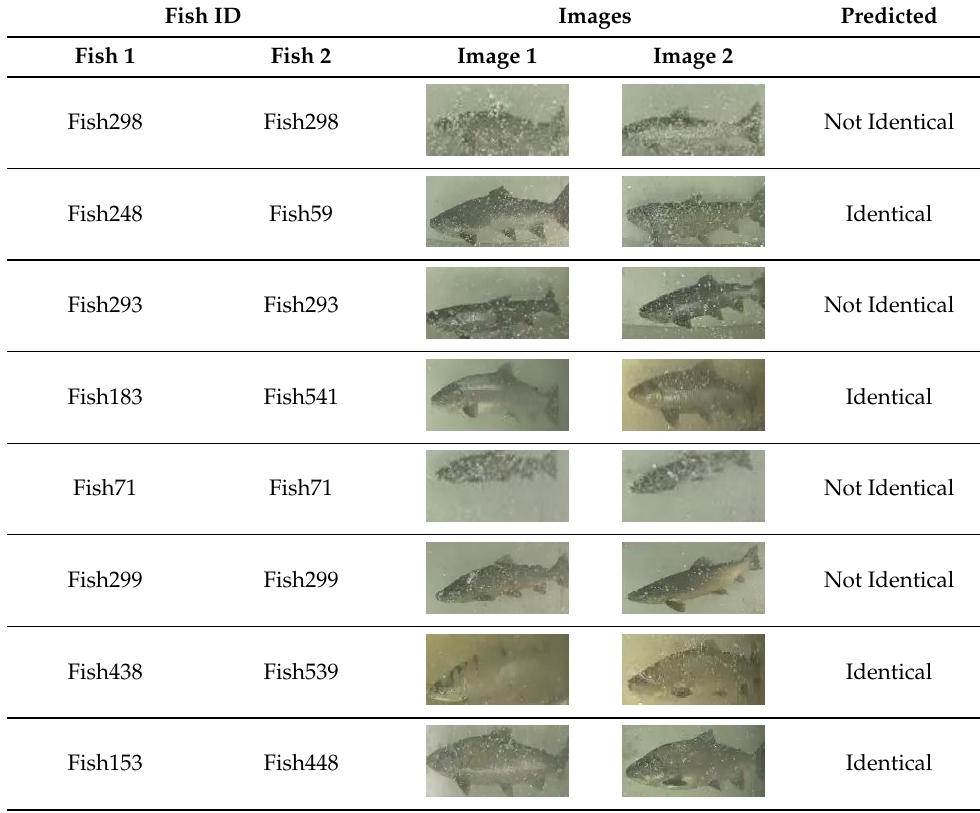
Table 5. Randomly chosen sample fish in NINA204 dataset that were incorrectly